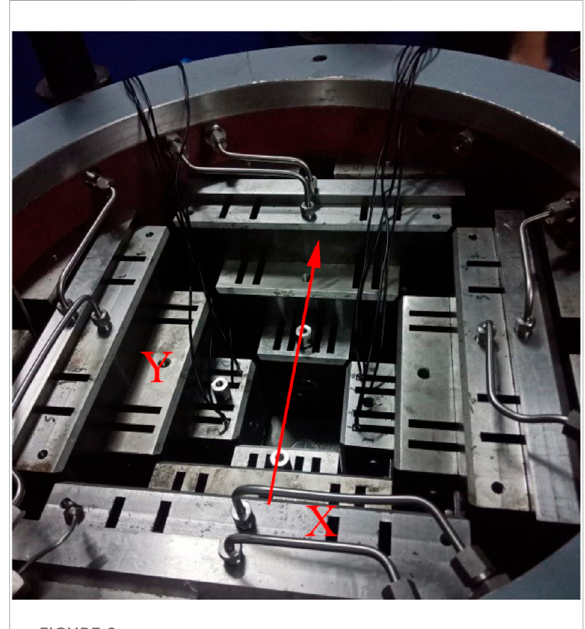
FIGURE 1 Overall diagram of experimental device.